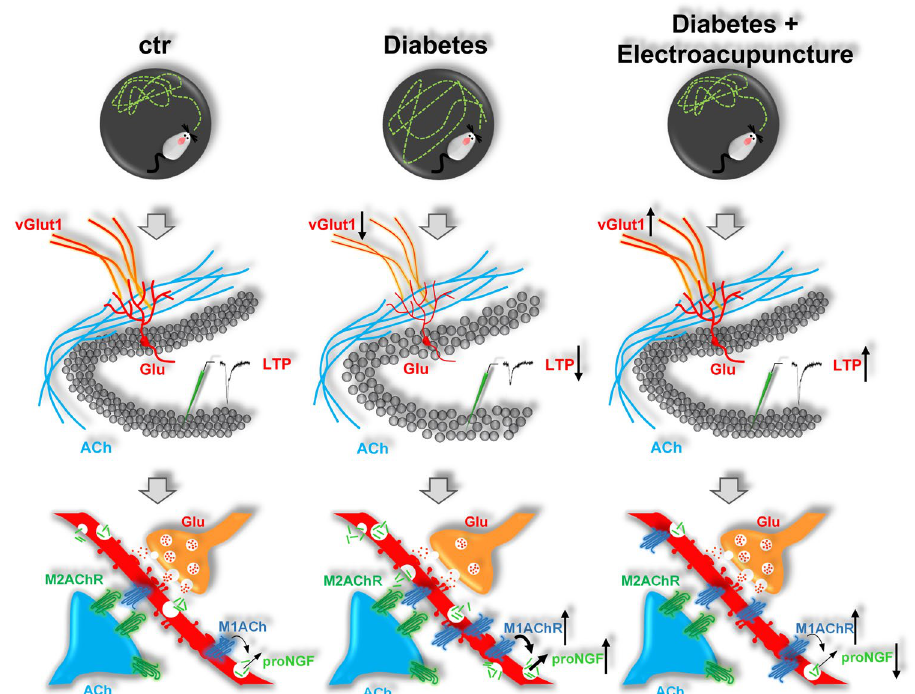
Figure 6. Summary drawing of the experimental findings. The behavioural alteration found in the Morris water maze early after diabetes induction in young adult rats (upper part of the figure), were concomitant to the reduction in glutamatergic transmission (middle part of the figure), neuronal loss in the hippocampus, the depression of synaptic plasticity and the increased expression and possibly activity of the M1-subtype muscarinic receptor, resulting in increased activity dependent release of the proNGF (lower part of the figure). The electroacupuncture normalized spatial learning and memory performance in diabetic rats, improved glutamatergic neurotransmission, LTP and the activity-dependent release of proNGF, modulating the response of muscarinic receptor to acetylcholine